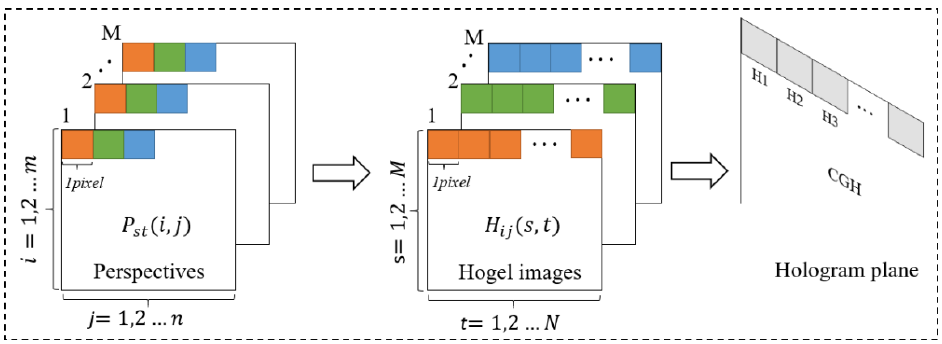
Figure 3. Conventional pixel re-arrangement process from captured perspectives.